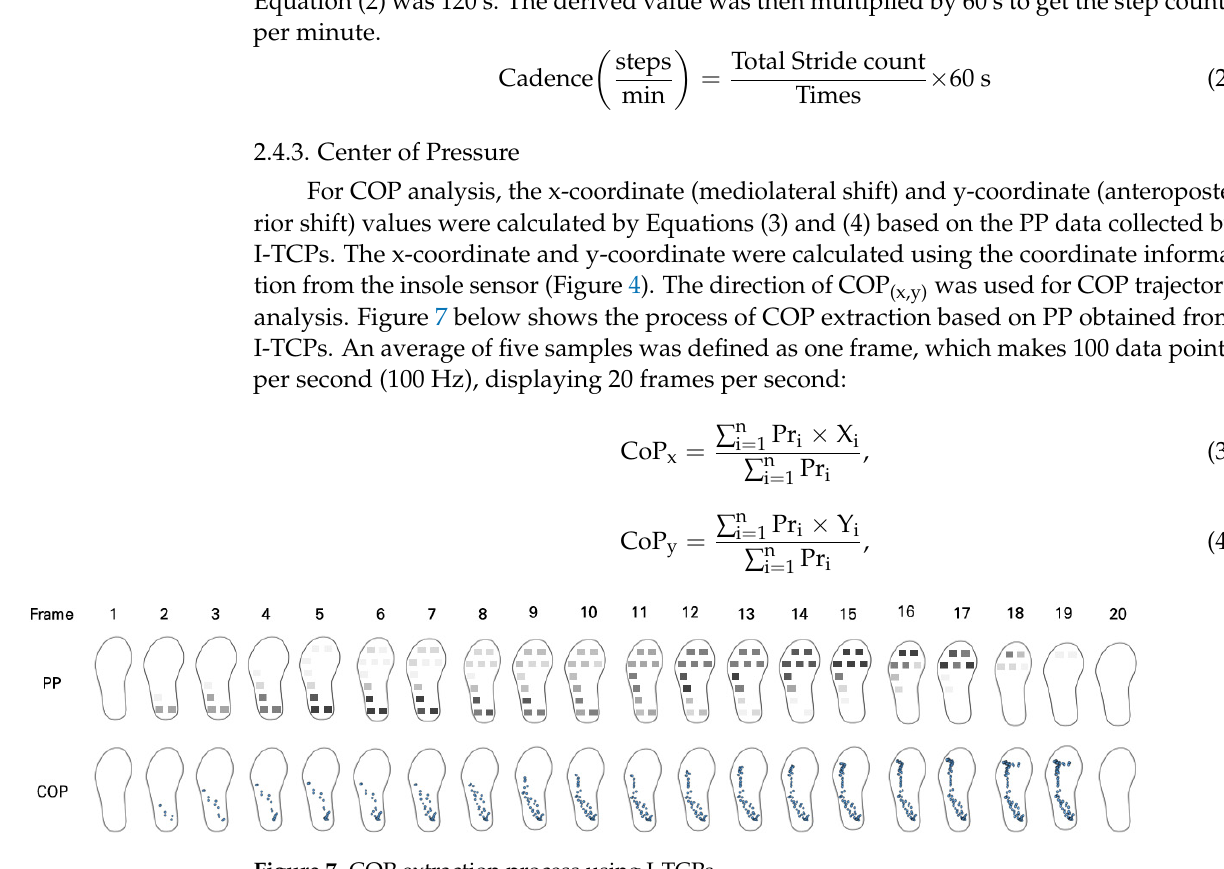
Figure 7. COP extraction process using I-TCPs.